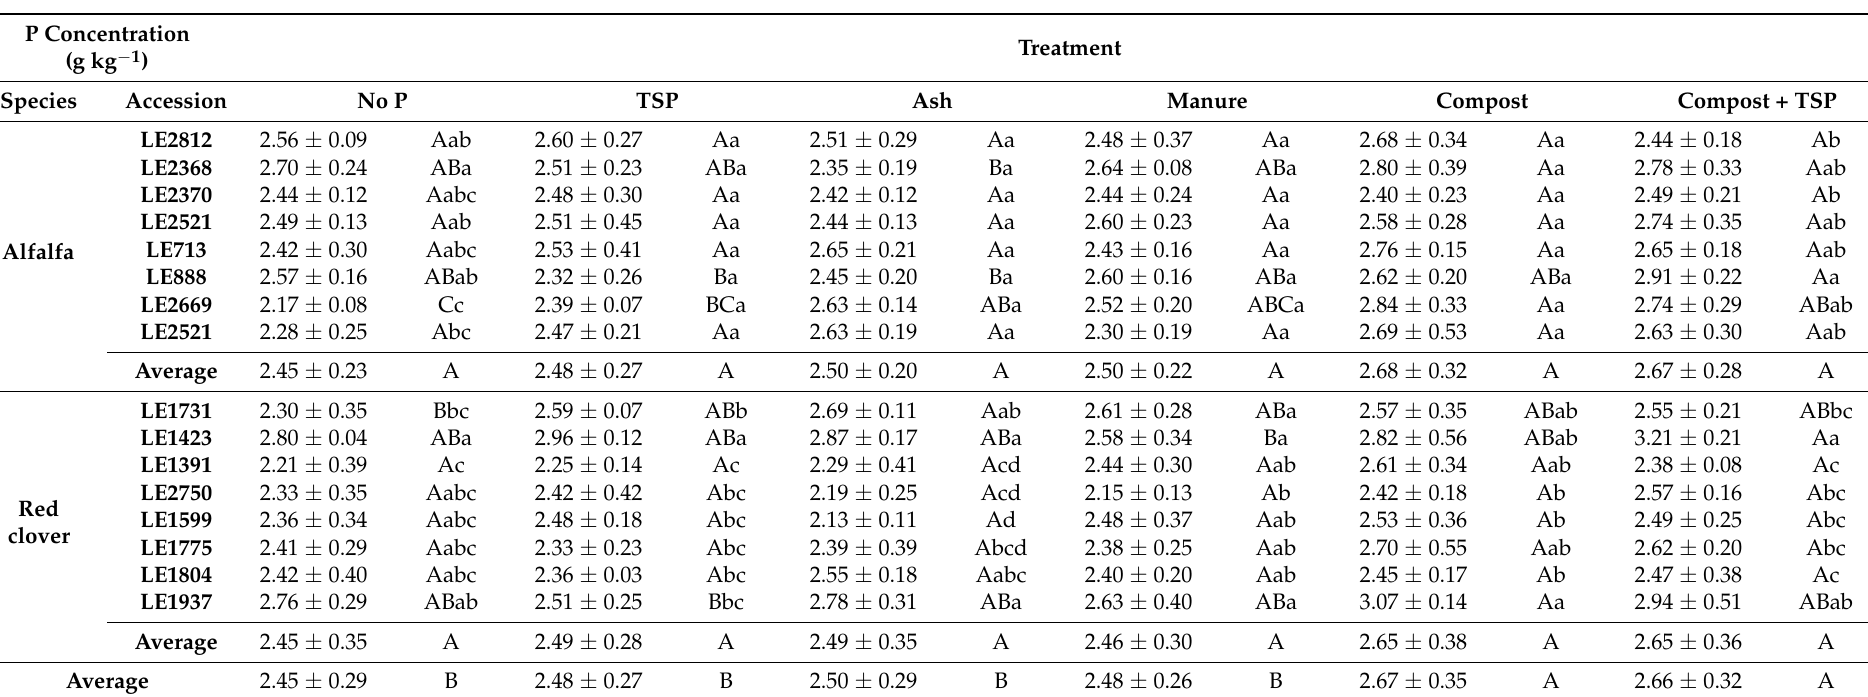
Table 5. Phosphorus (P) concentration of selected accessions of alfalfa and red clover from the six studied treatments (no P, TSP, ash, manure, compost, and compost + TSP) in